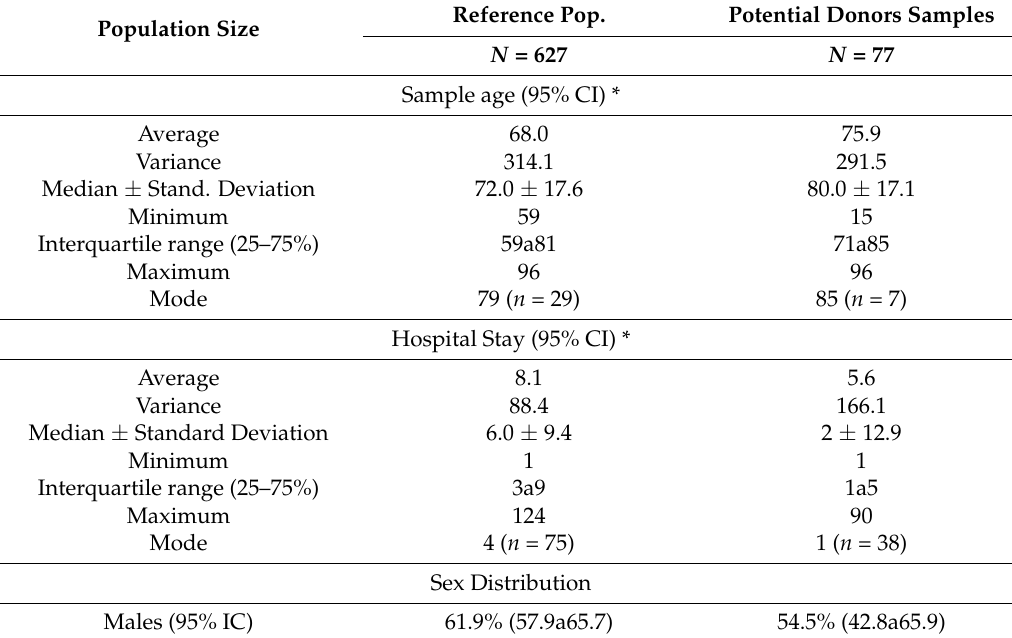
Figure 1. Sample inclusion criteria performance results. Table 3. Socio-demographic data.